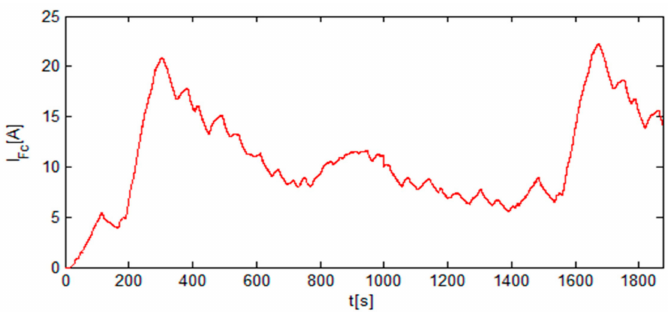
Figure 22. Fuel cell current corresponding to low frequency component.